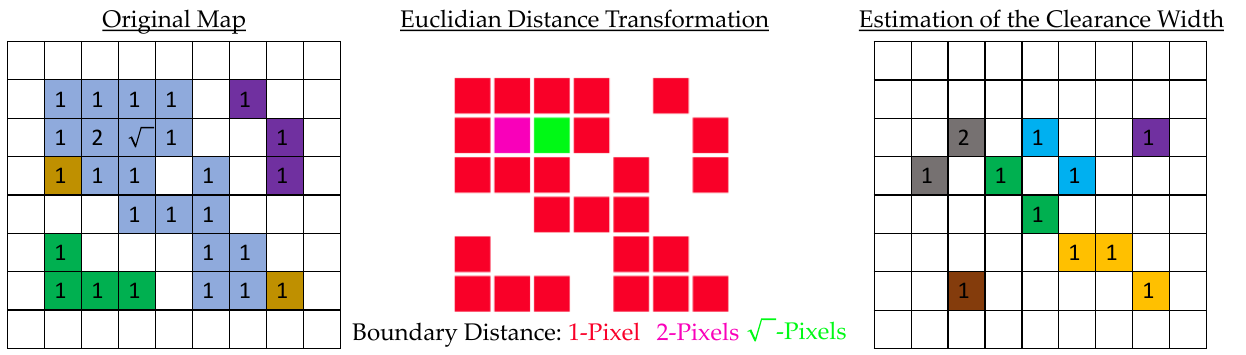
Figure 4. Clearance width estimation: map with Euclidian distance values, colored representation, and estimated clearance width of each path